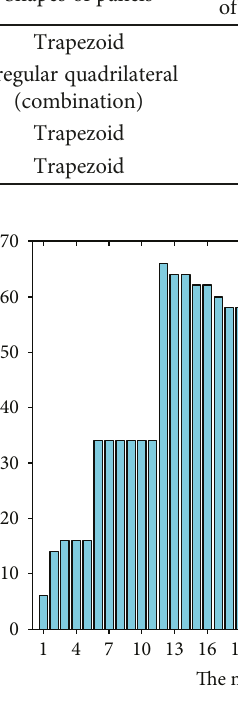
Figure 4: Number of panels in each ring of the GBT main